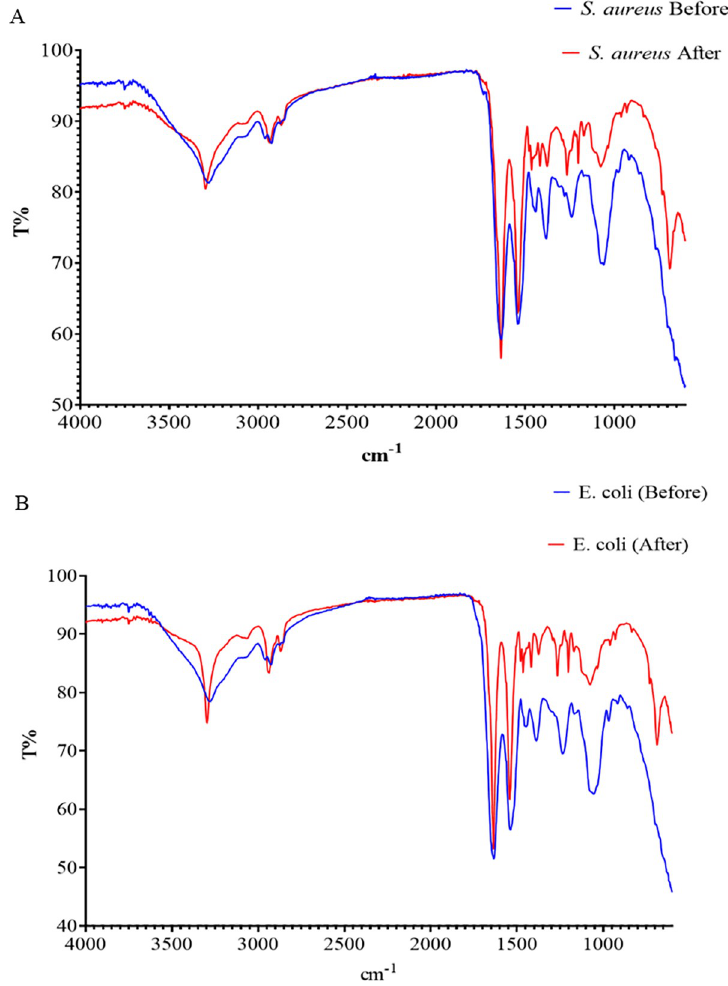
Fig 5. Fourier Transform Infrared Spectroscopy (FTIR) spectrum of E . coli , and S . aureus seeded in greywater before after the inactivation process with 0.028 mg mL -1 of Cu/Zn NPs, at pH 6 and after 60 min; a) S . aureus ; b) E . coli .